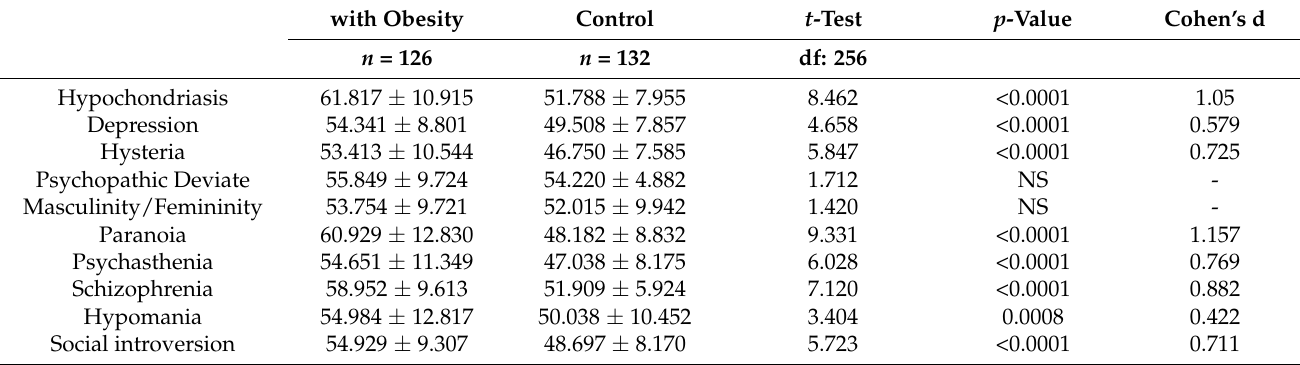
Table 1. Mean differences in Basic Scale of the MMPI-2 test between the groups of mothers of children with and without